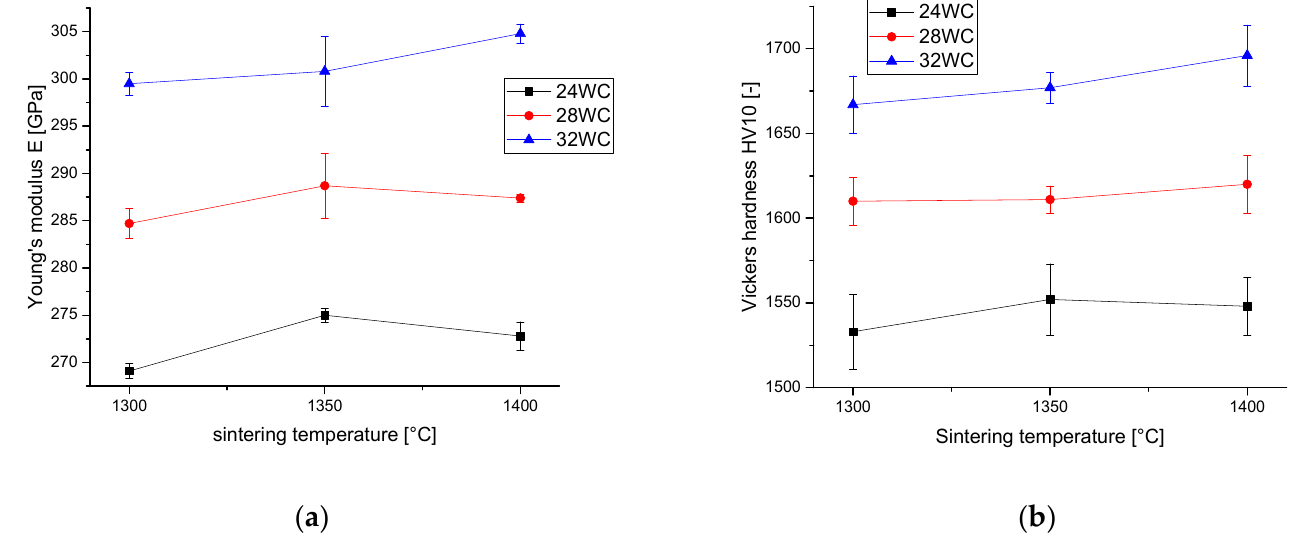
Figure 1. ( a ) Young’s modulus of TZP-WC composites depending on tungsten carbide volume fraction and sintering temperature. ( b ) Vickers hardness HV10 of TZP-WC composites depending on tungsten carbide volume fraction and sintering temperature.